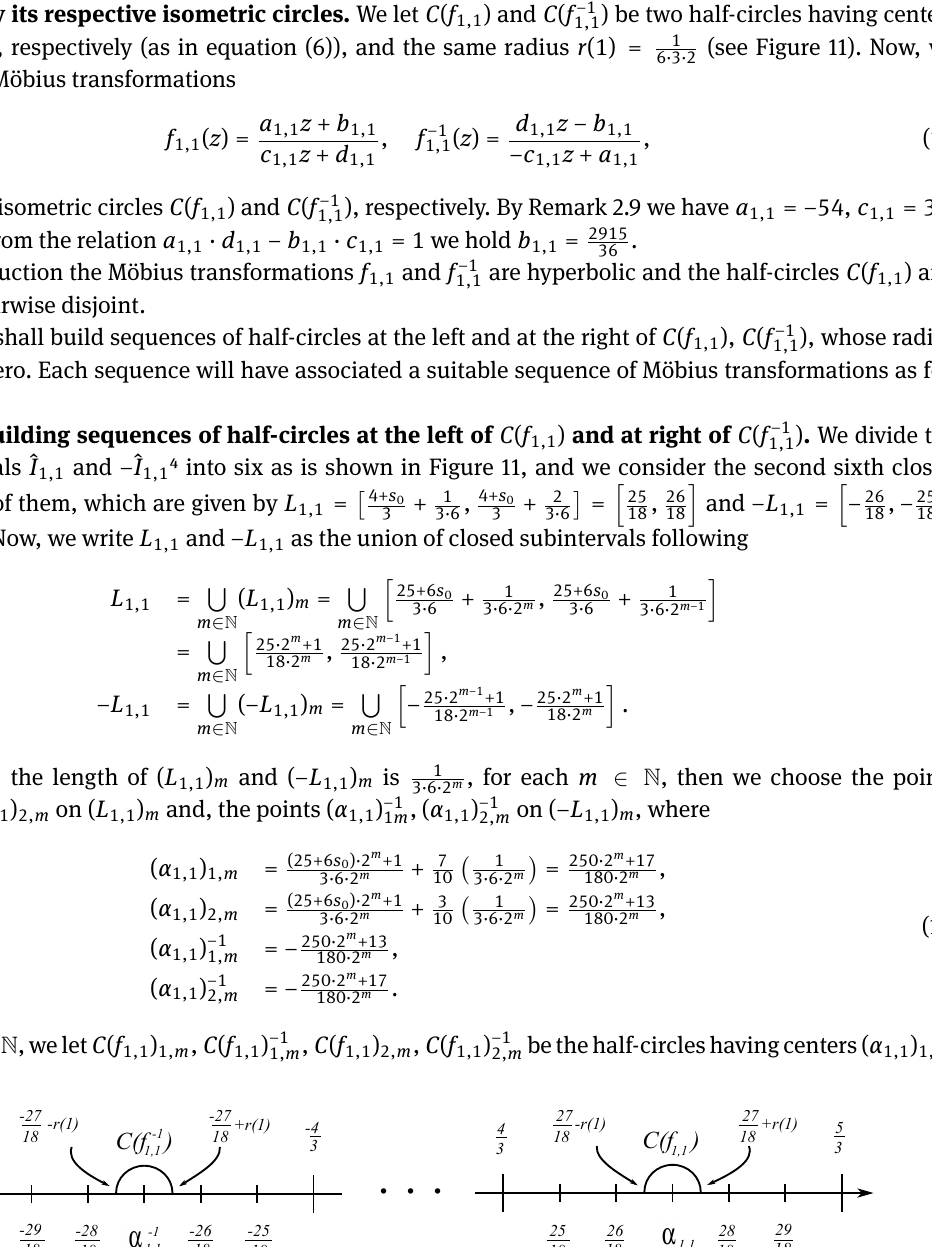
( α 1,1 ) −1 , ( α 1,1 ) 2, m and ( α 1,1 ) −1 1, m